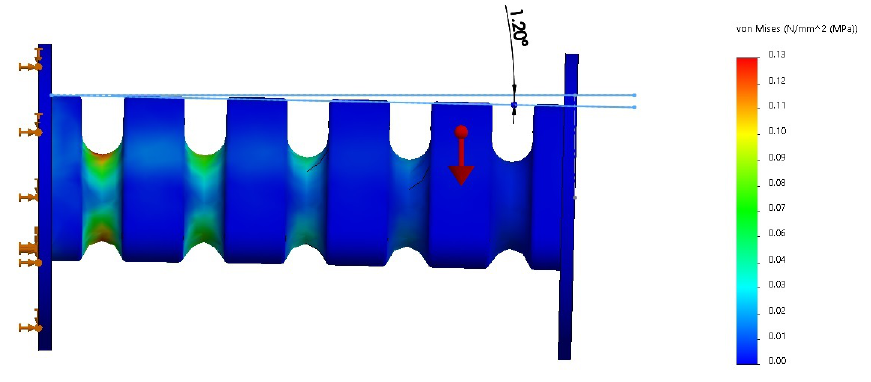
Figure 7. No-load simulation of soft joint.